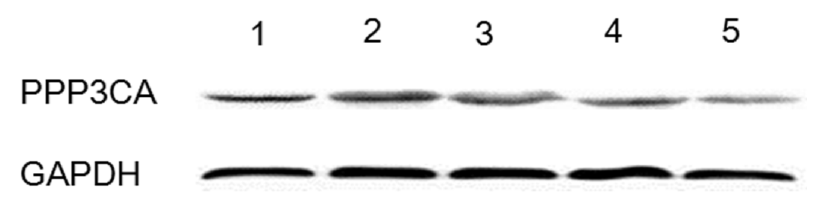
Figure 8. Western blotting of Tianfu goat PPP3CA protein levels in five muscle tissues. The samples 1–5 represent cardiac muscle, biceps femoris muscle, abdominal muscle, longissimus dors muscle and soleus muscle, respectively, ( n =